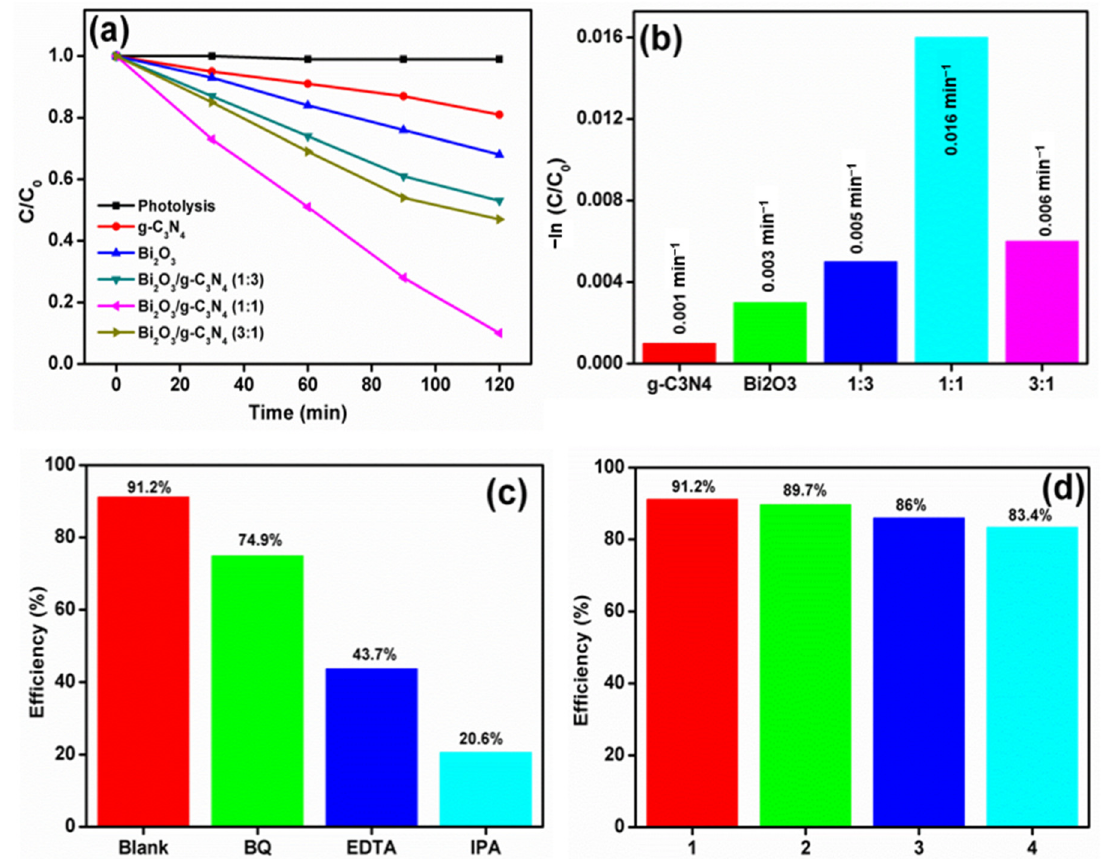
Figure 6. ( a ) Degradation plot, ( b ) pseudo 1st order kinetics, ( c ) scavenger’s test and ( d ) recycling